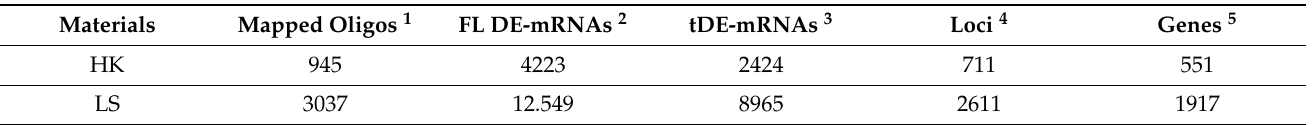
Table 8. Summary of data from identifying FL-mRNAs by use of microarray results (oligo sequences) and the following in silico target gene